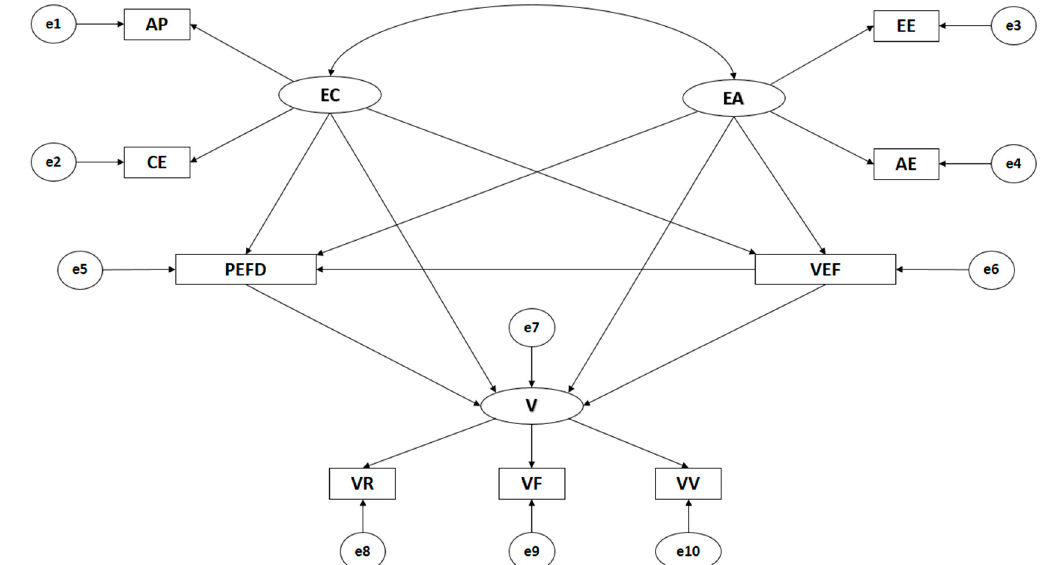
Figure 1. Theoretical model.